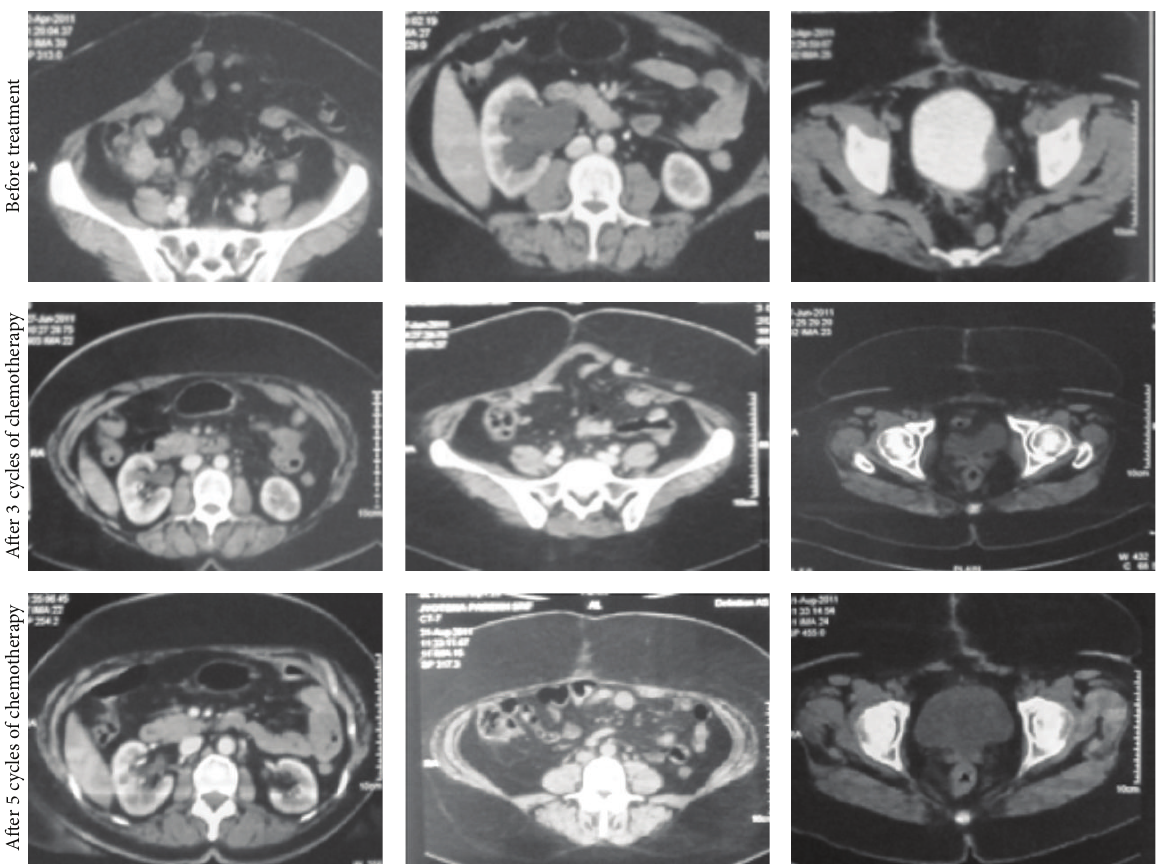
Figure 5: Pretreatment and after 3 and 5 cycles of